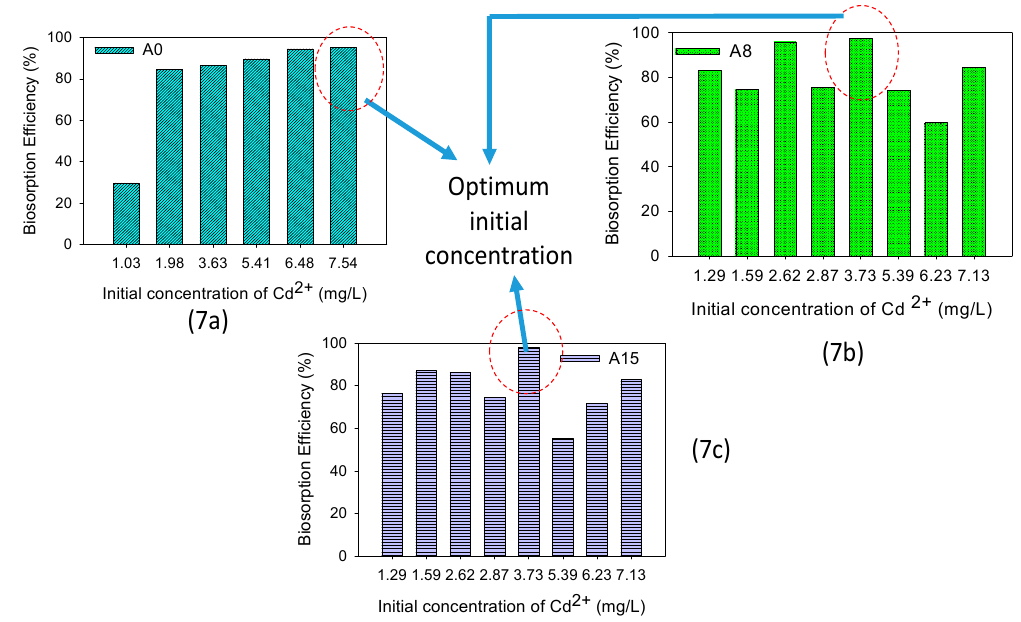
Figure 7. Effect of Cd 2+ initial concentration on sorption efficiency of Cd 2+ onto dried biosorbent of Aphanothece sp. for ( a ) adsorbent A0 (CO 2 enrichment of 0.04%), ( b ) adsorbent A8 (CO 2 enrichment of 8%) and ( c ) adsorbent A15 (CO 2 enrichment of 15%) (W 0 = 0.1 g/L, t contacts = 60 min, T = 30 °C).